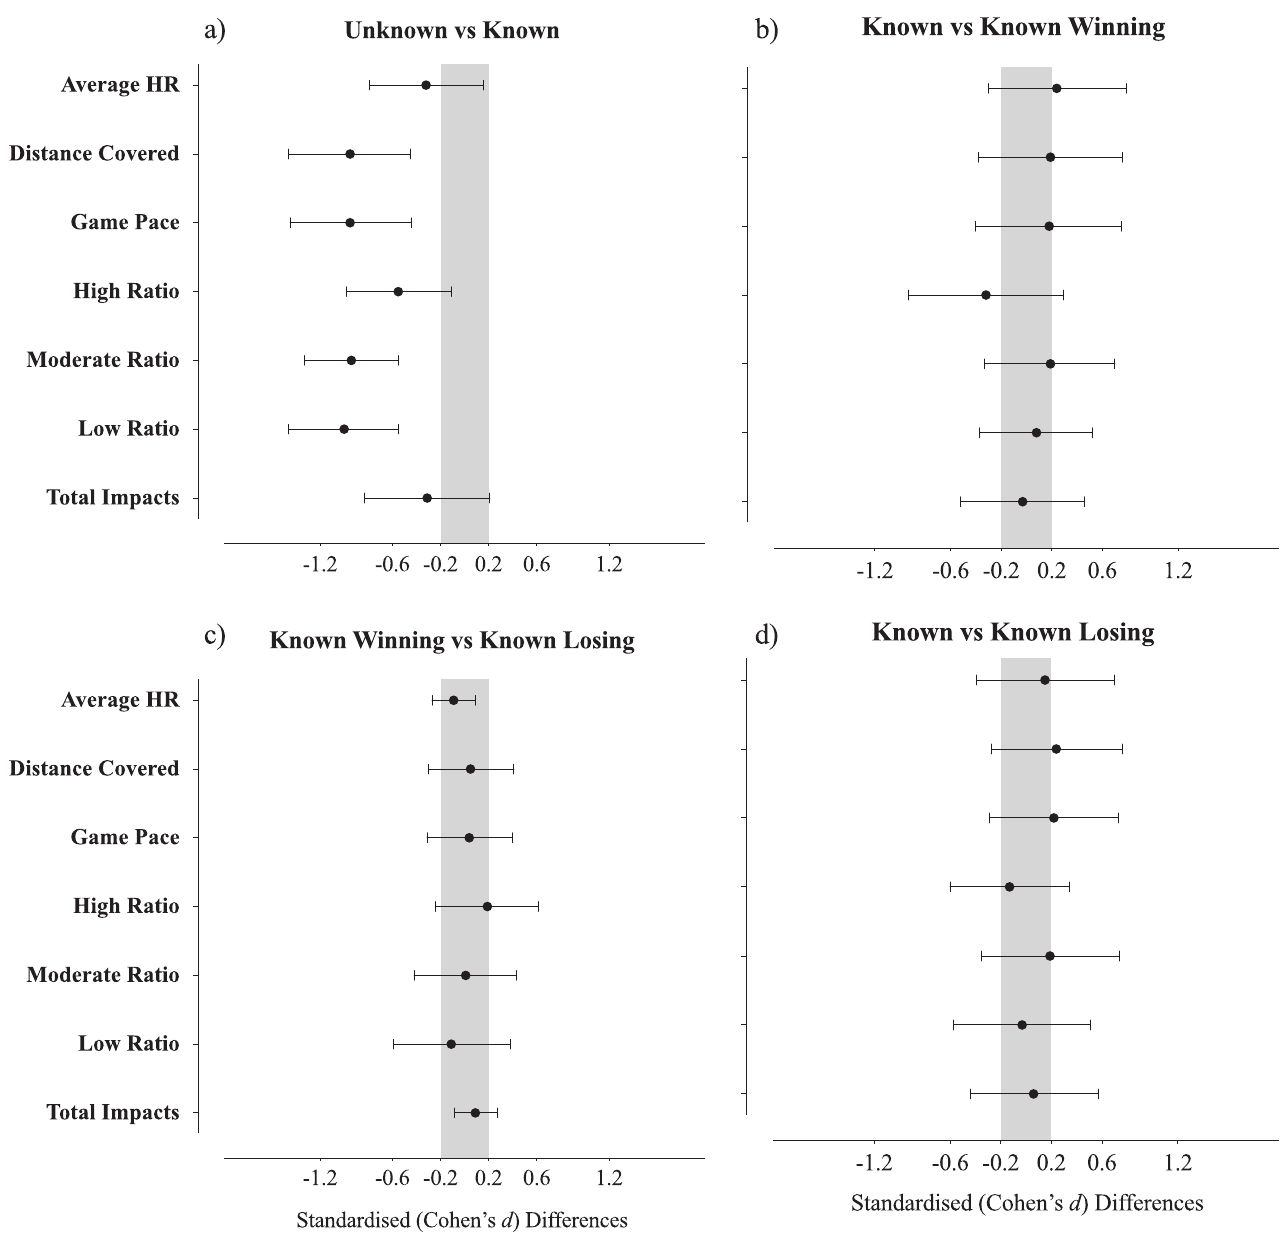
Fig 2. Standardised (Cohen) differences in physical variables according to (a) Not knowing vs knowing the task duration; (b) Know the task duration and start winning vs Know the task duration and start losing; c) Know the task duration vs Know the task duration and start winning; d) Know the task duration vs Know the task duration and start losing. Error bars indicate uncertainty in the true mean changes with 90% confidence